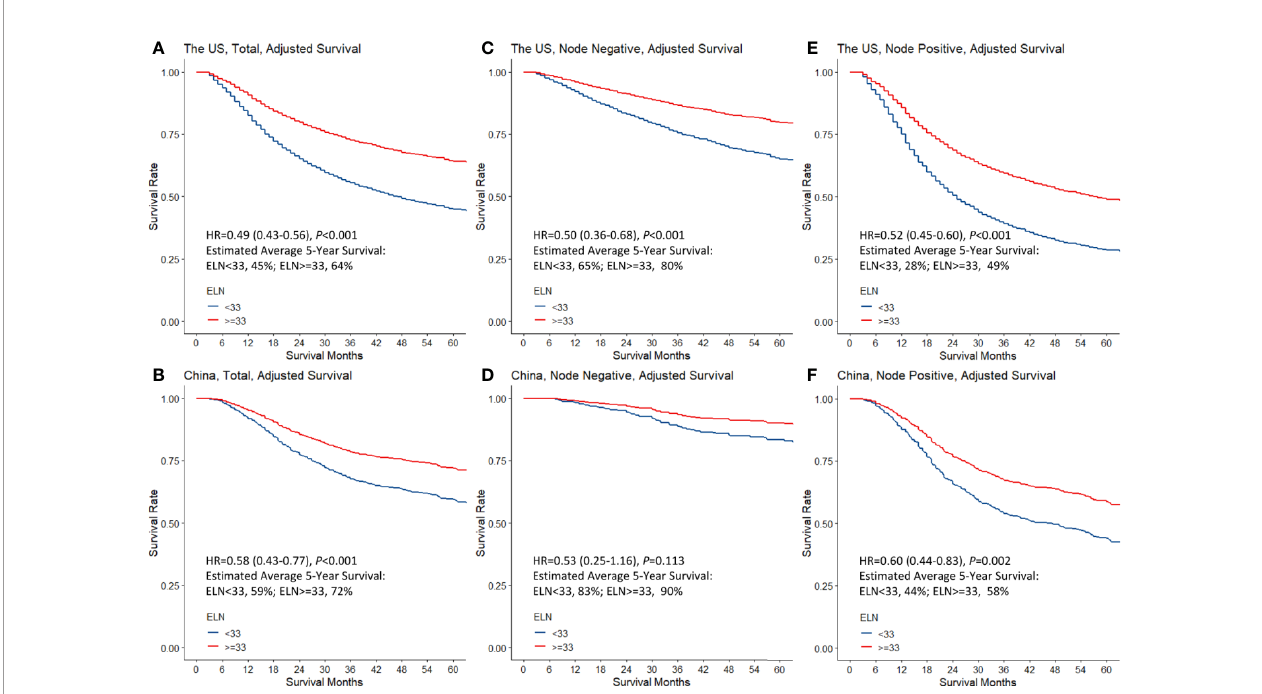
FIGURE 2 | Strati fi cation of adjusted overall survival by the determined optimal breakpoint of examined lymph node (ELN) number (33) in total patients with resected non-metastatic gastric adenocarcinoma (A, B) , and in patients with node-negative (C, D) and node-positive diseases (E, F) in the US and China cohorts. Multivariable Cox proportional hazards regression was used adjusting for year of diagnosis, sex, age, tumor local invasion, differentiation, location, size, and resection type. Positive lymph node count was also adjusted for in overall and node-positive cases. HR, hazard ratio.